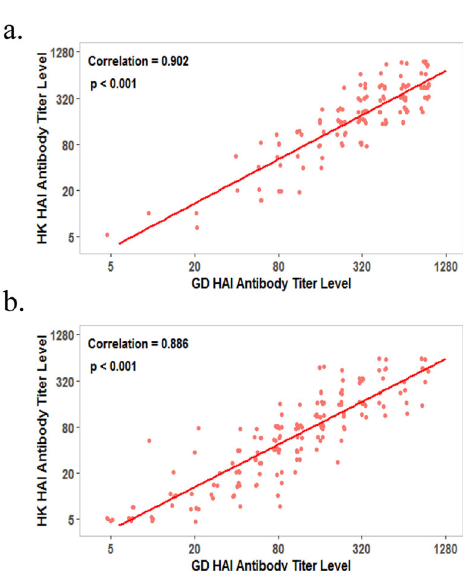
Fig. 6 Serum hemagglutination inhibition antibody responses to each of the two fi fth epidemic H7N9 strains tested were highly correlated. HAI antibody titers generated by AS03-adjuvanted recombinant H7 ( a ) and MF59-adjuvanted recombinant H7 ( b ) against HPAI and LPAI H7N9 viruses from the fi fth